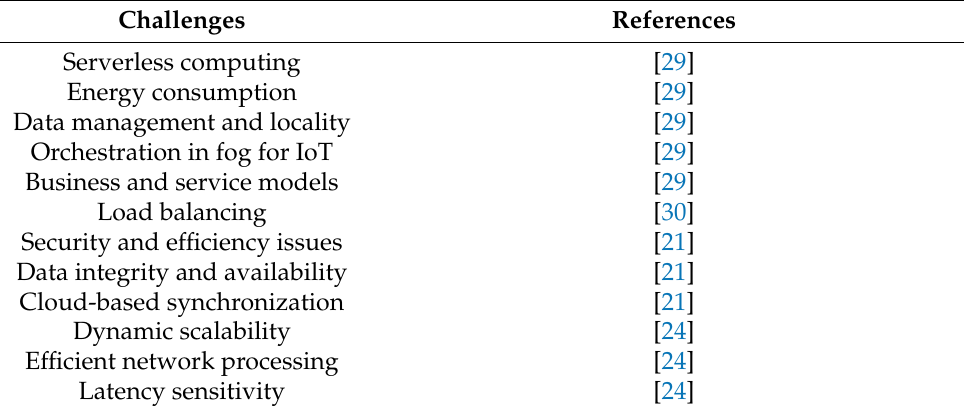
Table 1. Challenges in architecture for cloud, fog, and edge